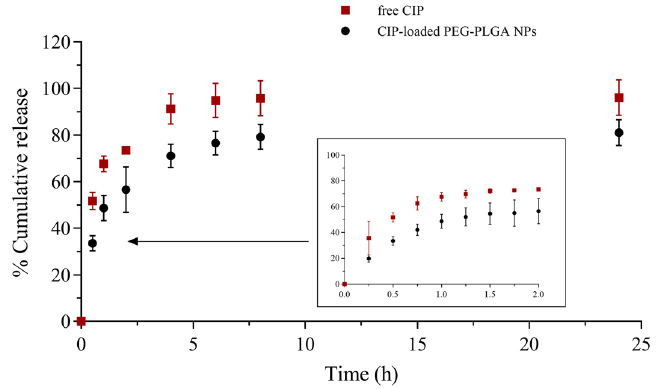
Figure 3. The cumulative release of free CIP ( ■ ) and CIP-loaded PEG–PLGA NPs ( ● ) in tris-buffer saline solution, pH 7.4 over 24 h. The samples were shaken at 100 rpm at 37 °C, in the dark. The error bars in the plots represent the standard deviation obtained from three independent experiments of each sample.